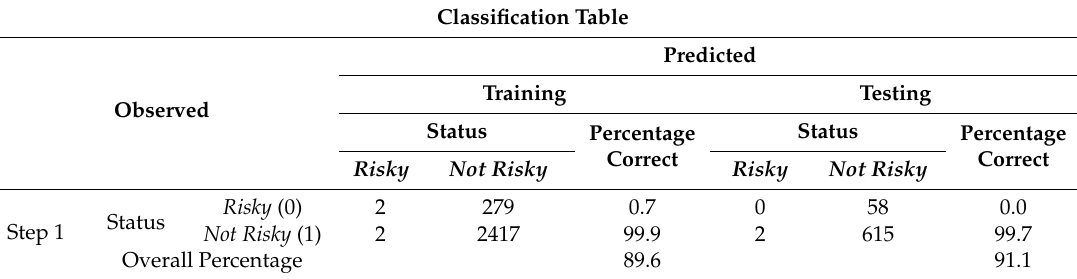
Table 4. Logistic regression classification table for default 0.5 cut-off